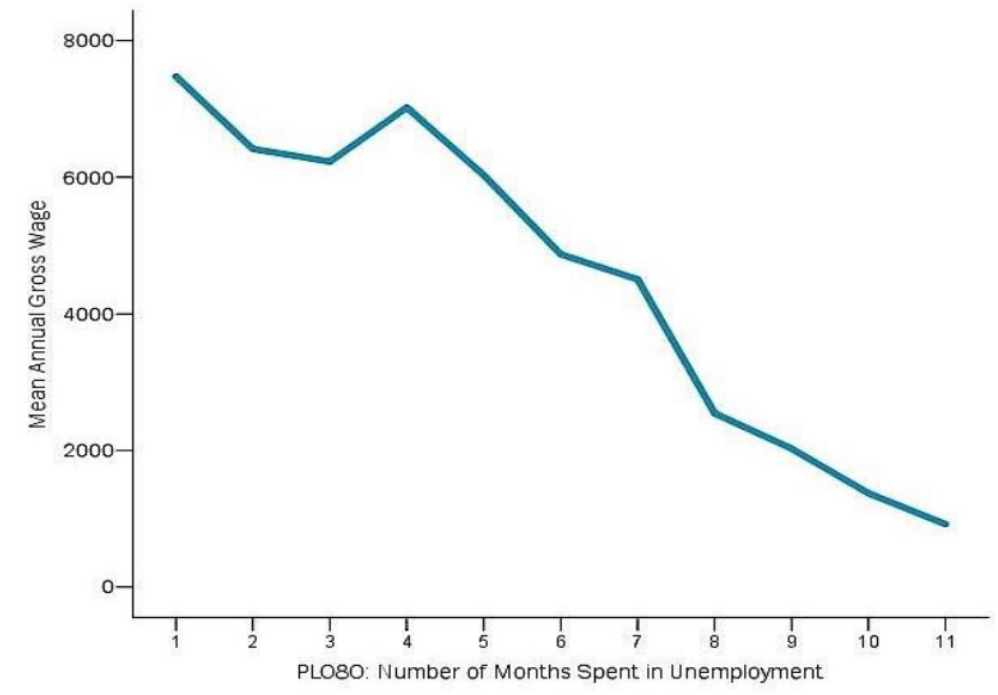
Figure 12. Annual gross labour income of precarious workers as a function of unemployment duration (2019). Data source: EU-SILC (2020).